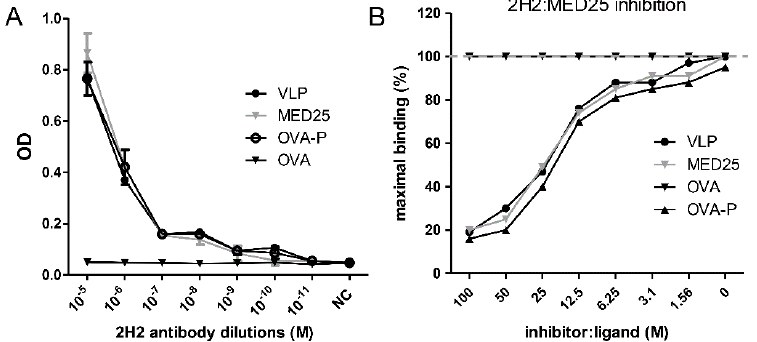
Figure 4. VLP and MED25 are co-antigens of 2H2. ( A ) Binding activity of 2H2 to VLP and MED25 were evaluated by ELISA as described in Materials and methods. OVA-P and OVA were used as positive and negative control respectively; ( B ) Inhibition of 2H2 binding to immobilized EV71 VLP was evaluated by ELISA as described in Materials and methods. VLP and OVA-P were used as the positive control and OVA as the negative control. The y-axis represents OD as the percentage of maximal binding, which is determined as the mean reading without inhibitors (100% binding is marked by the gray dot line for